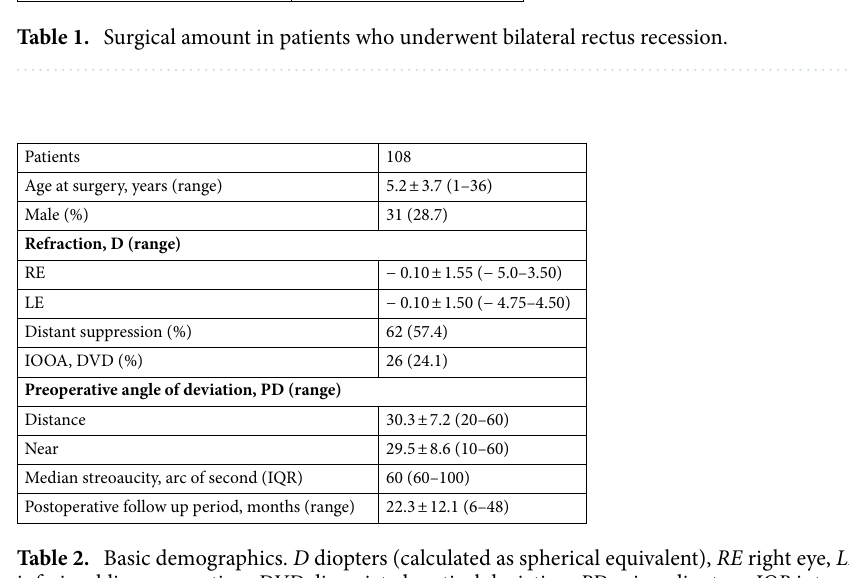
Table 2. Basic demographics. D diopters (calculated as spherical equivalent), RE right eye, LE left eye, IOOA inferiorobliqueoveraction, DVD dissociated vertical deviation, PD prism diopters, IQR interquatile